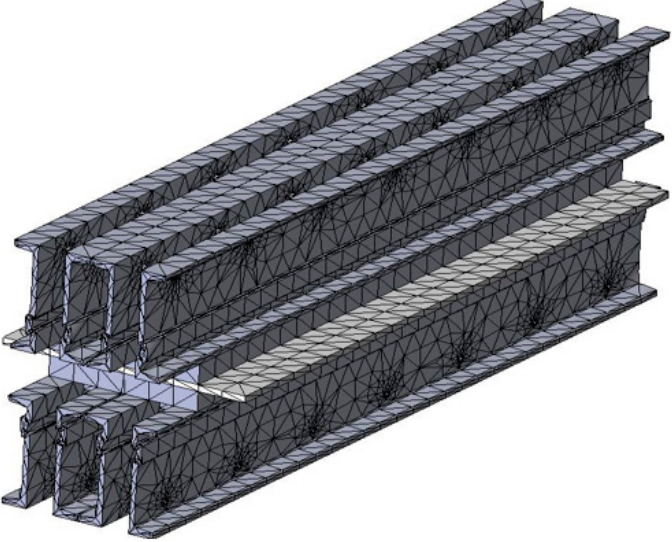
Figure 10. Discretion of the modified belt vulcanization press when seven spacers are used.